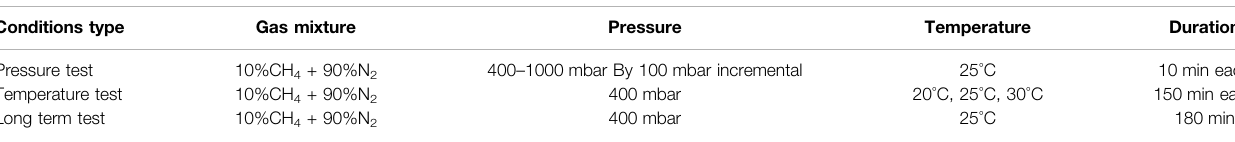
TABLE 2 | Experimental protocol